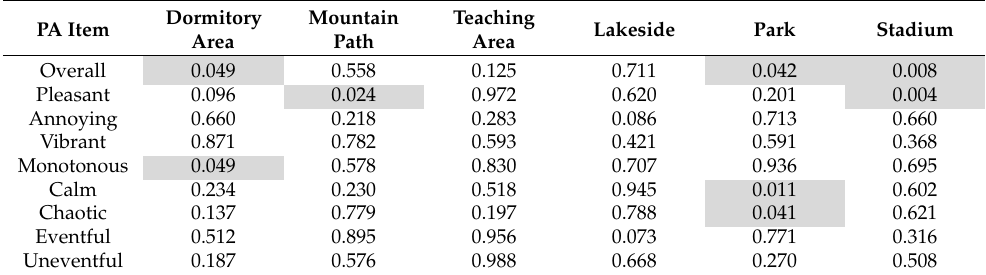
Table 3. Mann–Whitney U test p -value results of the two teams.